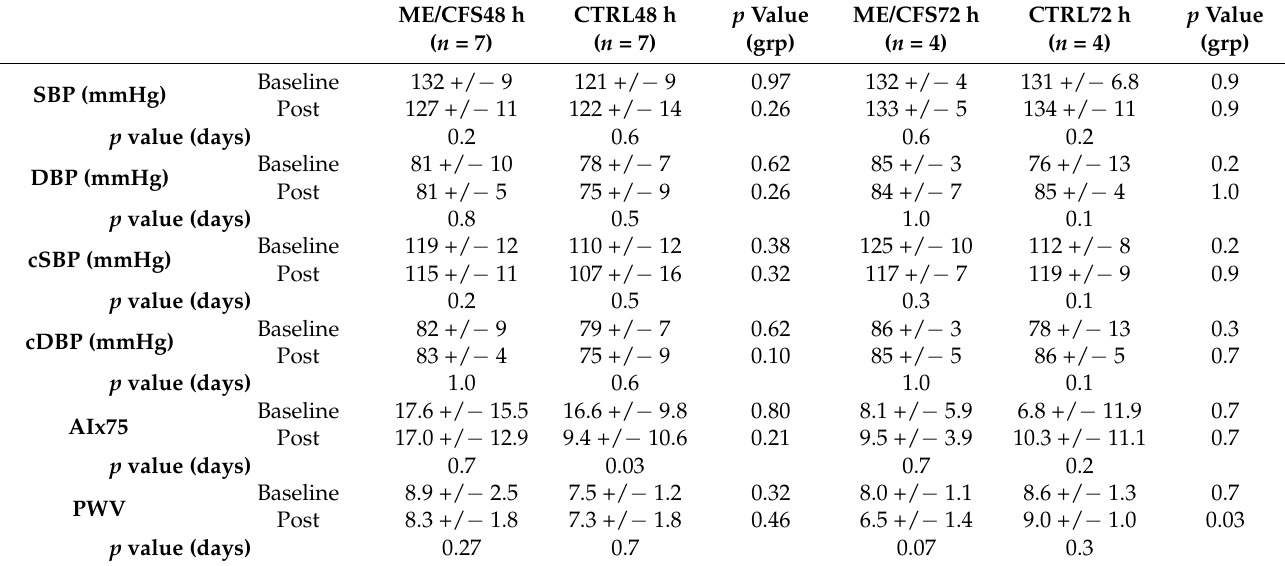
Table 2. Mean (SD) maximal data of physiological variables from maximal cycle test at baseline and at 48 and 72